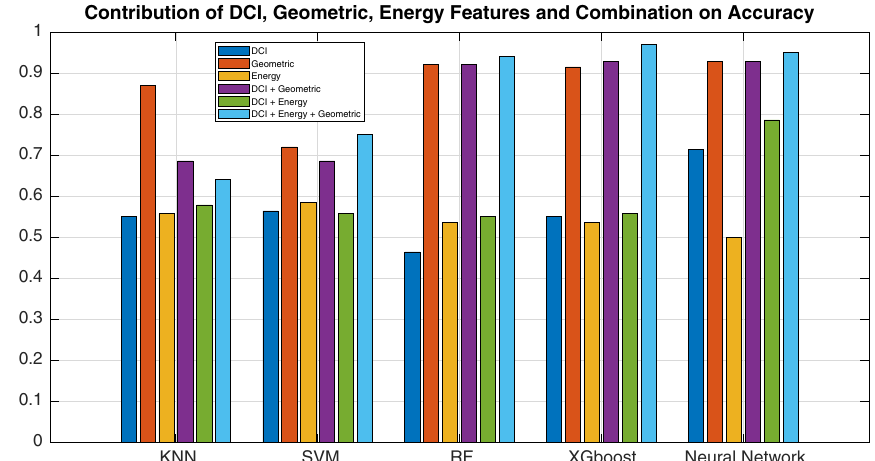
Figure 5. Contribution of geometrical, DCI, and energy-related features to the accuracy of the model.